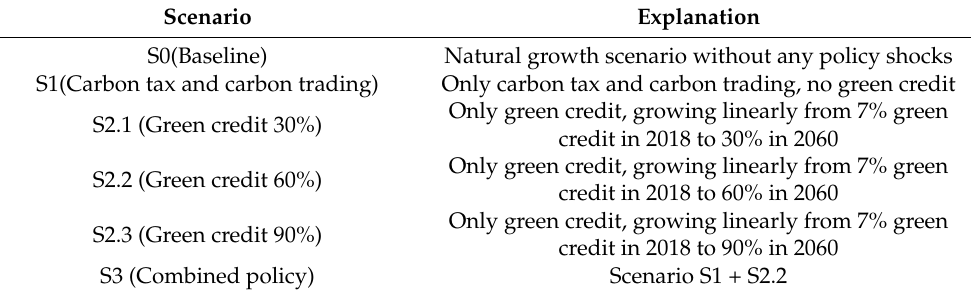
Table 3. Green credit scenario setting. Scenario Explanation S0(Baseline) Natural growth scenario without any policy shocks S1(Carbon tax and carbon trading) Only carbon tax and carbon trading, no green credit Only green credit, growing linearly from 7% green S2.1 (Green credit 30%) credit in 2018 to 30% in 2060 Only green credit, growing linearly from 7% green credit in 2018 to 60% in 2060 Only green credit, growing linearly from 7% green credit in 2018 to 90% in 2060 Scenario S1 +